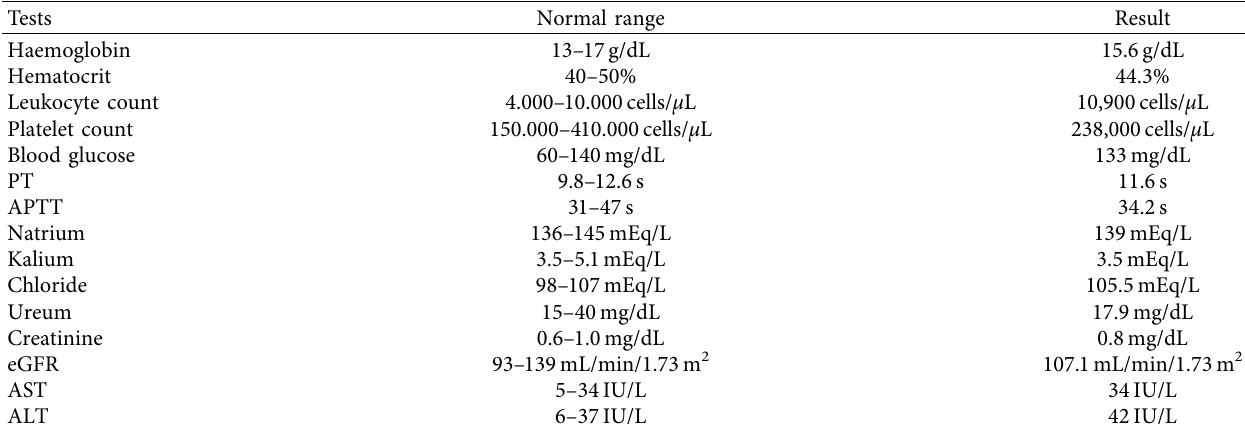
Table 1: Patient’s laboratory tests on admission.